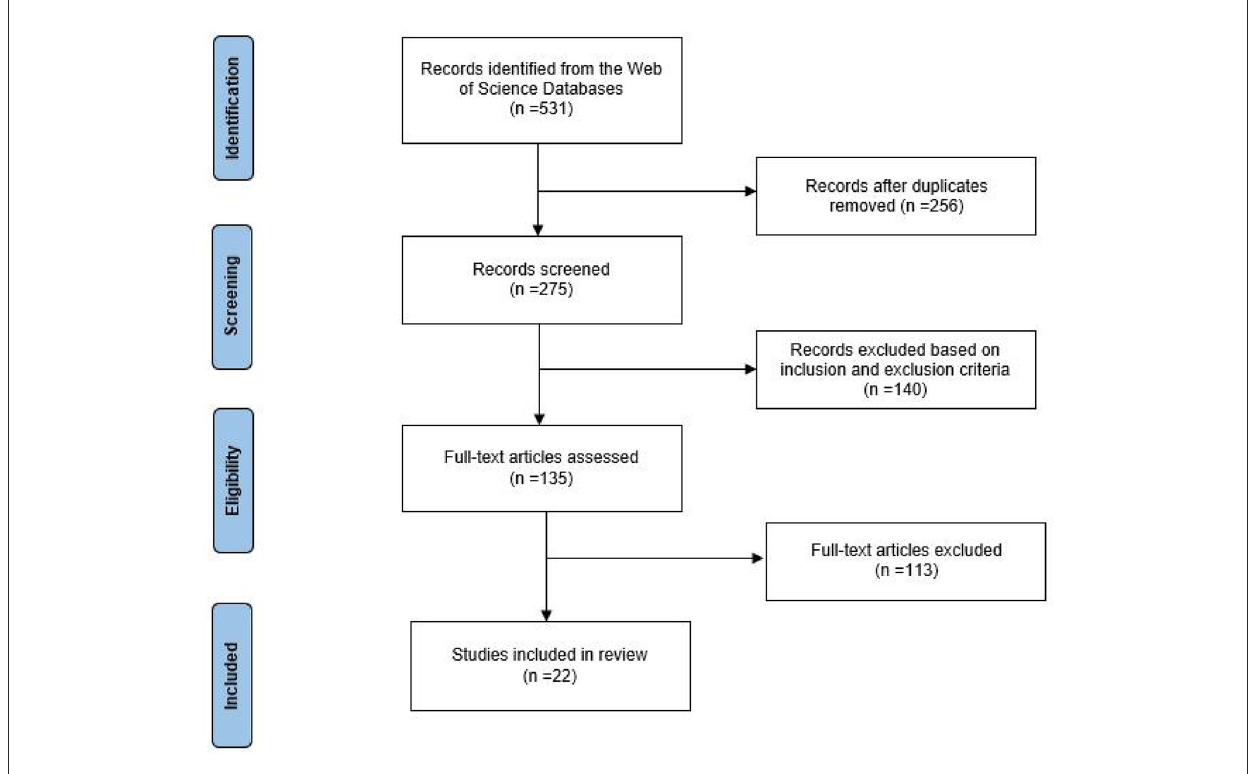
FIGURE1 A review process based on the PRISMA